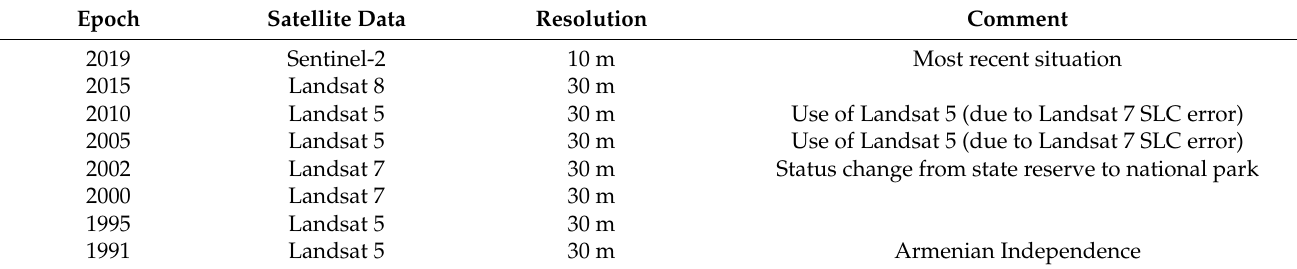
Table 2. Production epochs for the LULC maps and input satellite